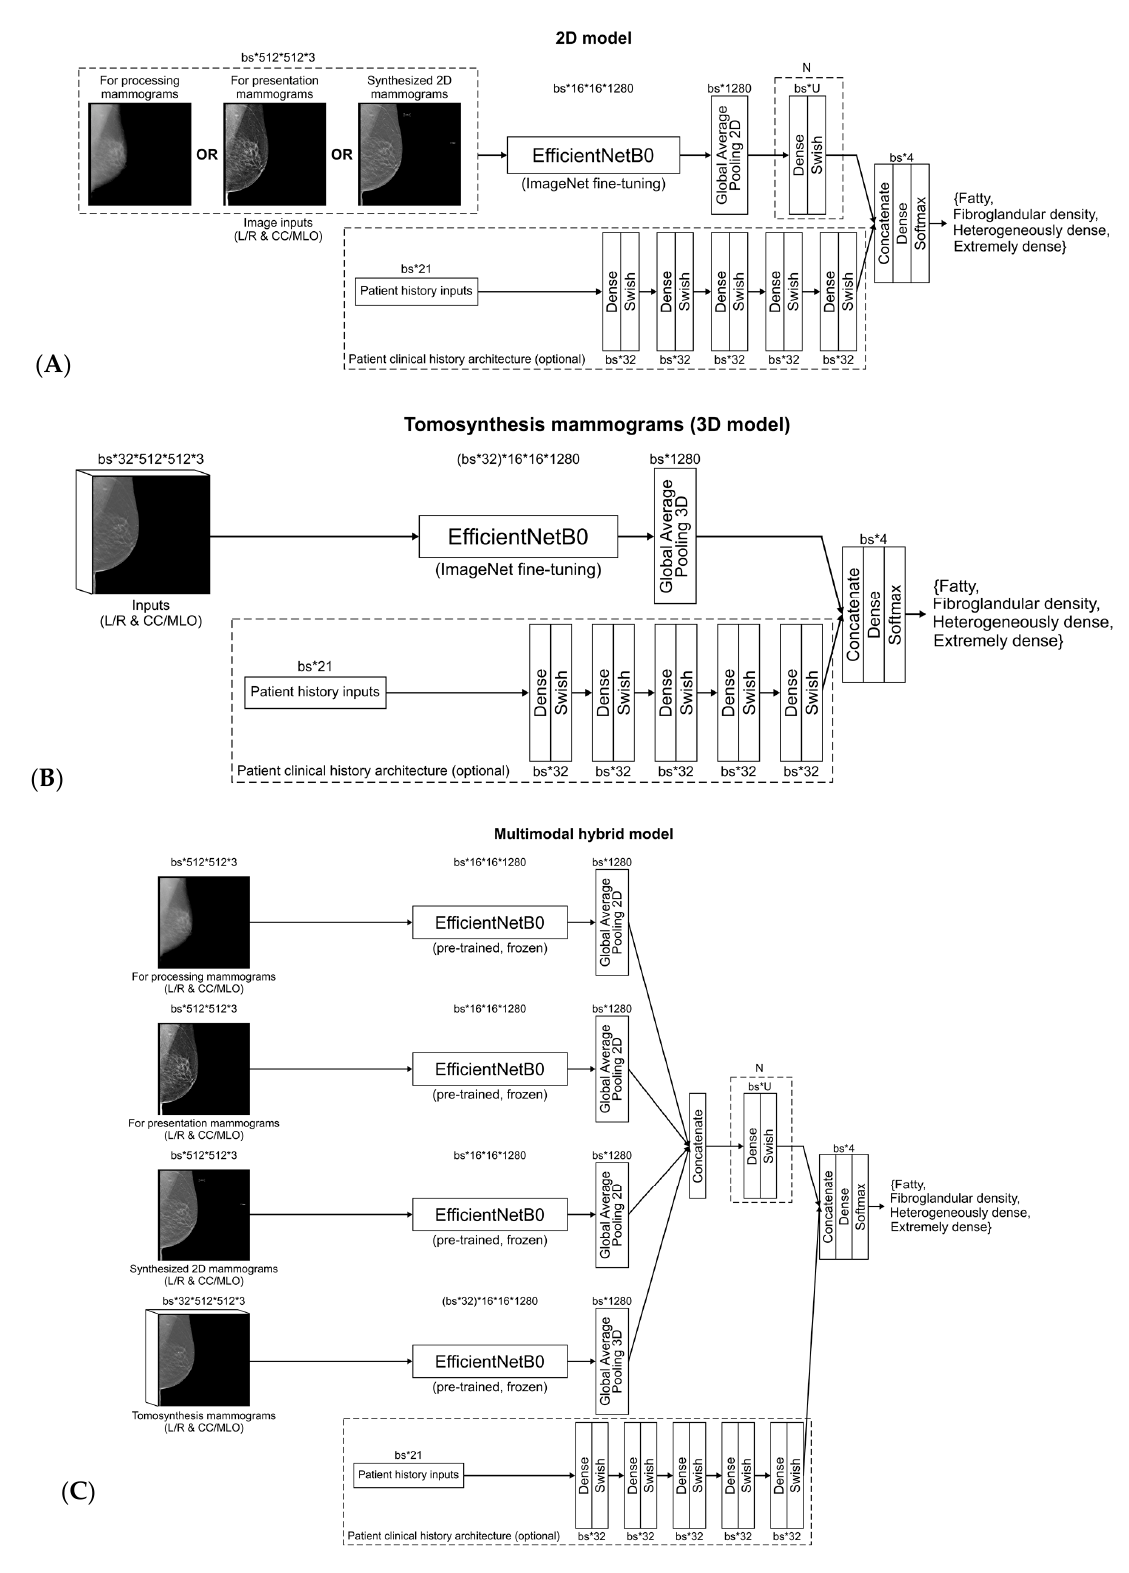
Figure 1. Convolutional neural network model for ( A ) 2D mammograms (i.e., for processing, for presentation, synthesized 2D), ( B ) digital breast tomosynthesis, ( C ) multimodal mammograms, with clinical